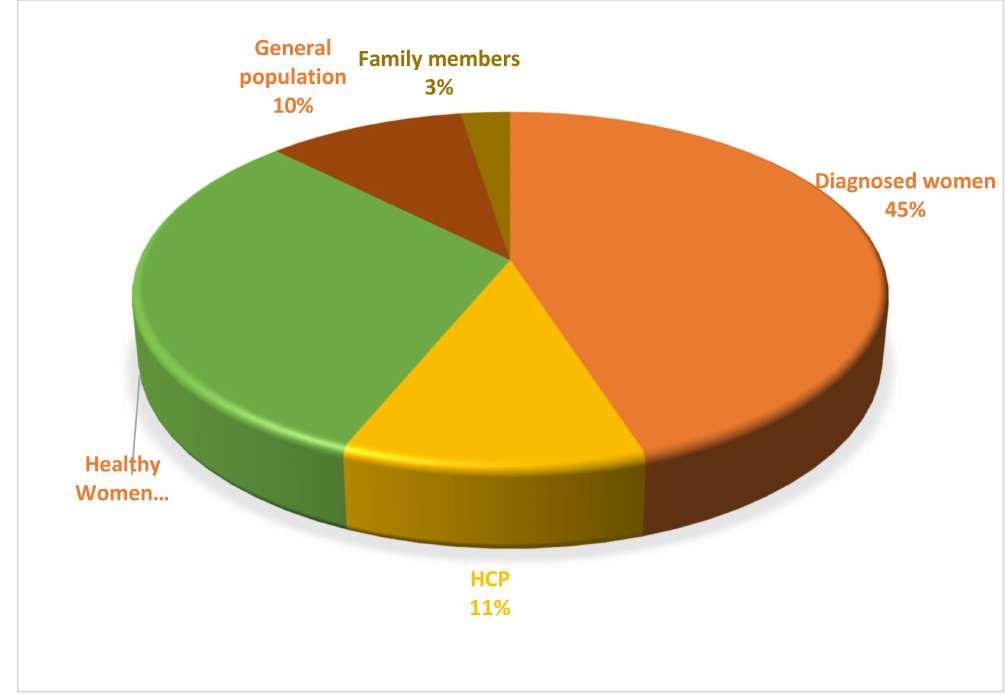
Figure 3. Categories of research participants in studies